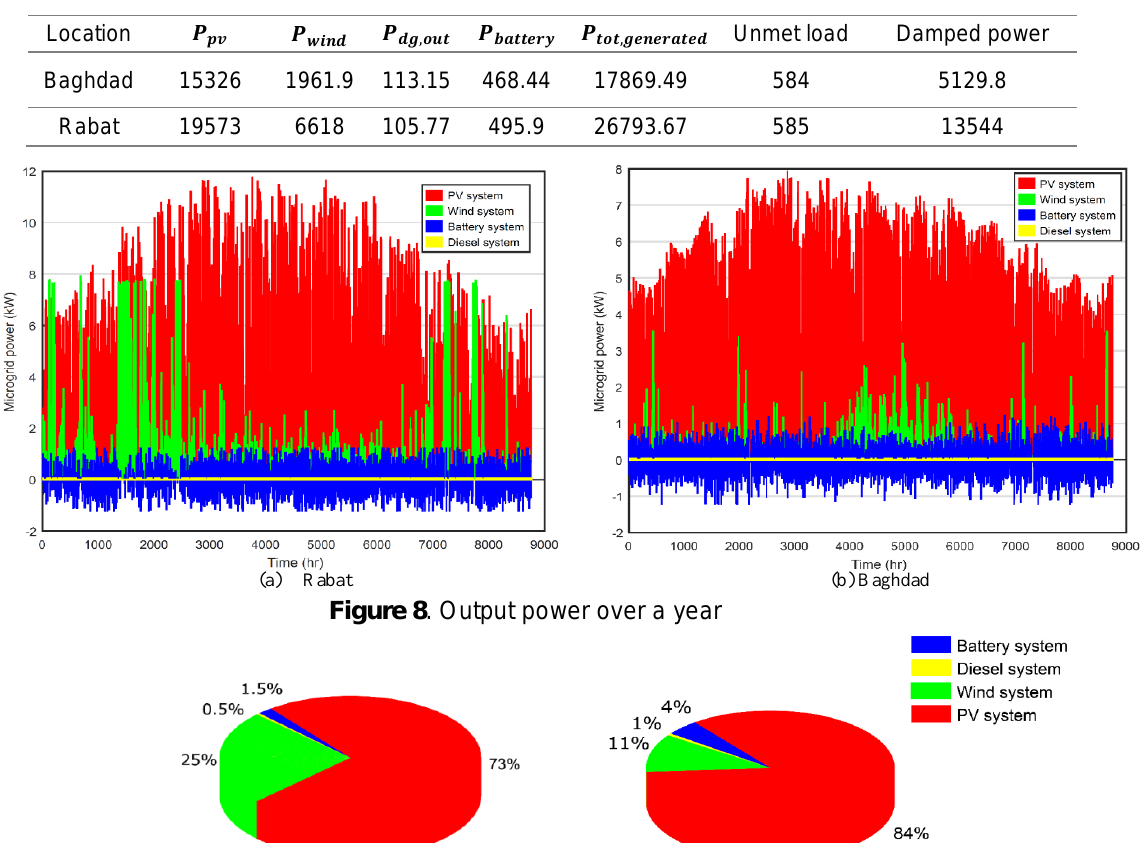
Figure 7. Damping power in Rabat and Baghdad Table 10. Annual power system evaluation in ( Kw)